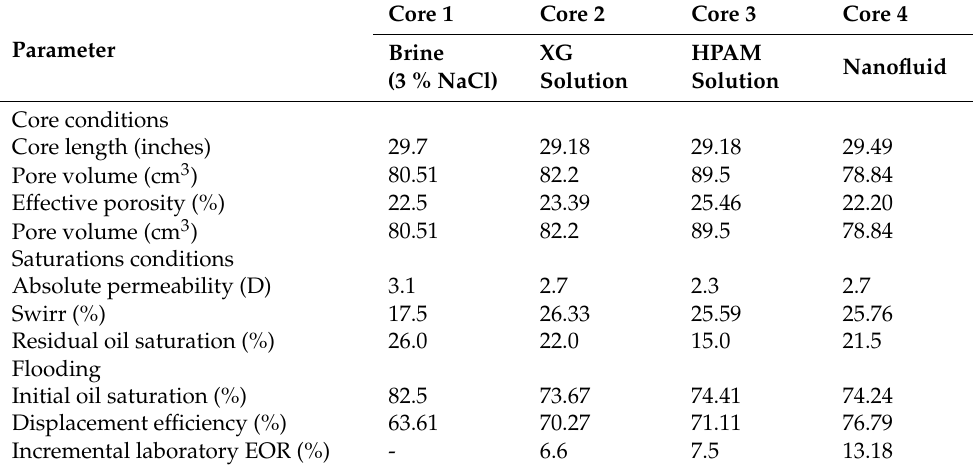
Table 2. Core flood